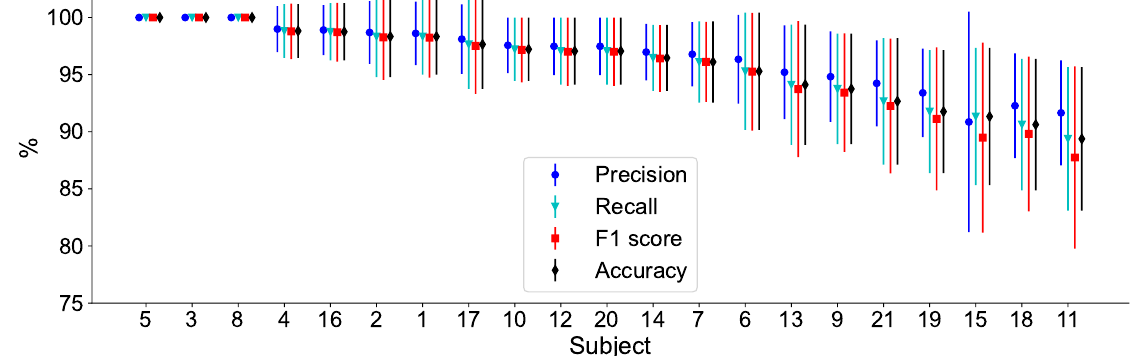
Figure 7. Highest average classification performance for each subject in the WM database. Mean ± standard deviation values are displayed for four classification performance measures: precision, recall, F1 score and accuracy. The subjects are ordered from the highest to lowest